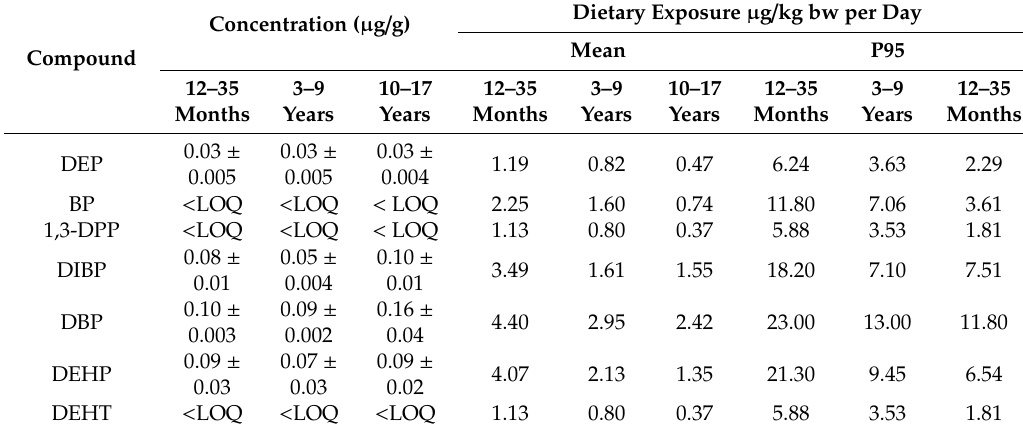
Table 4. Mean concentrations of migrants in pooled food samples and estimated dietary exposure of the Spanish child and adolescent